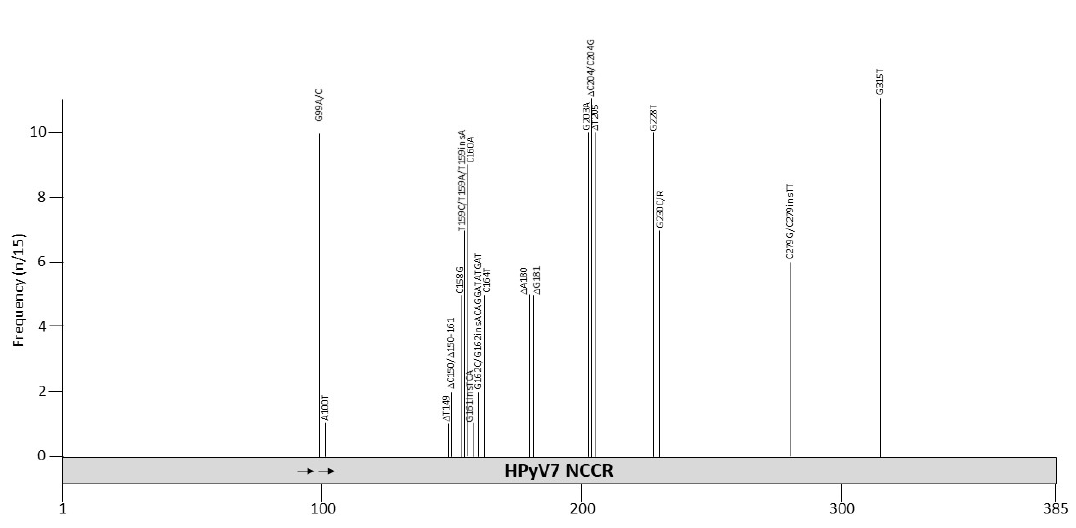
Figure 6. Mutations and their prevalence in variants of HPyV7 noncoding control region (NCCR). The numbering of the NCCR is from early to late with nucleotide 1 being the most proximal to the ATG start codon of the early genes and the most distal nucleotide, just upstream of the start codon of the VP2 gene. The number of times a peculiar mutation is found in the different variants is given as frequency (with n the number of times the mutation was described / total NCCR variant sequences available). Putative Large T antigen (LT) binding motifs 5 ′ -GRGGC-3 ′ ( → ) or 5 ′ -GCCYC-3 ′ ( ← ) are shown. The table summarizes the mutations, their location in the NCCR, and their frequency. For details see Table S1. Putative transcription factor binding sites are shown in Supplementary Table S2. Table 8. Frequency of mutations in the noncoding control region of HPyV7.